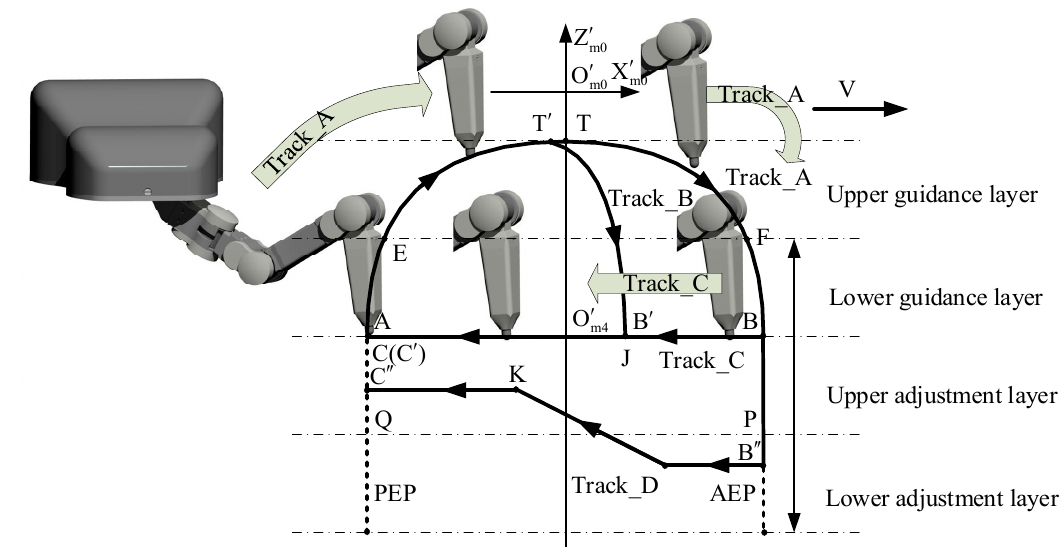
Figure 5. Projection of foot-end trajectory model in the XOZ plane of the trunk coordinate system.